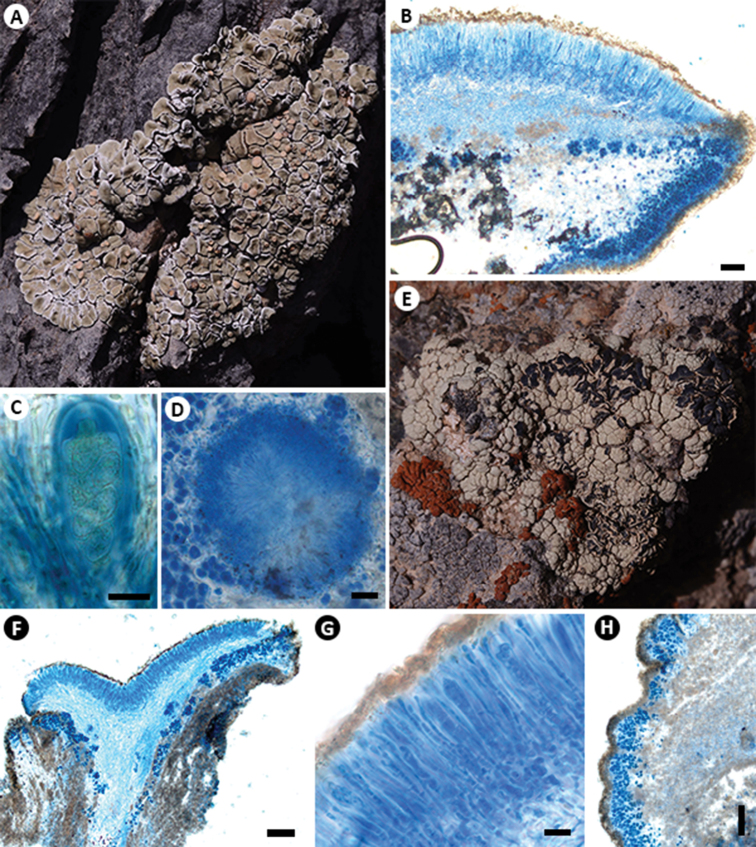
Rhizoplaca
callichroa (A–DKUN-L 19-62900): A habit B apothecial anatomy (LCB) C ascus and spores (Lugol’s) D section of pycnidia (LCB). R.
pachyphylla (E–HKUN-L 18-59446): E habit F section of apothecia G ascus and spores (LCB) H section of thallus (LCB). Scale bars: 100 μm (B, F, H); 10 μm (C, G); 20 μm (D).